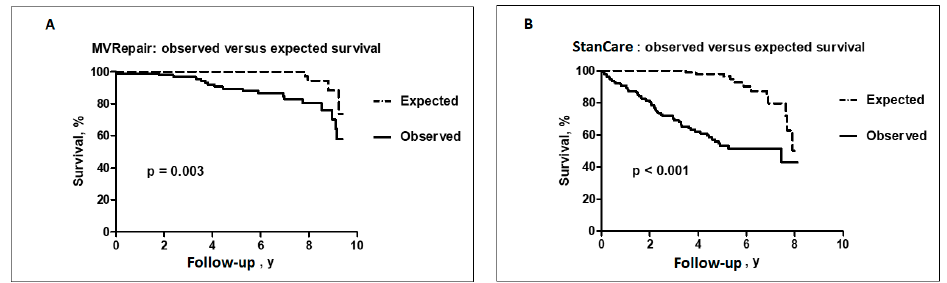
Figure 2. Observed versus expected survival in the MVRepair ( A ) and StanCare groups ( B ).